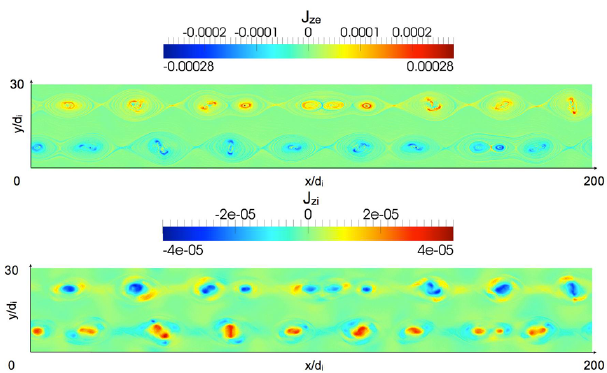
Fig. 4. Contour plots of the out-of-plane magnetic field without the guide field, B z − B g , normalized to B 0 at time (cid:127) ci t = 26 . 77. The core magnetic field shows a complex pattern. The S-shaped regions are visible in the coalescing area. The quadrupole structure of the Hall magnetic field in the coalescence-driven anti-reconnection is enclosed in white dashed rectangles. The white arrows indicate the outflow direction in anti-reconnection.